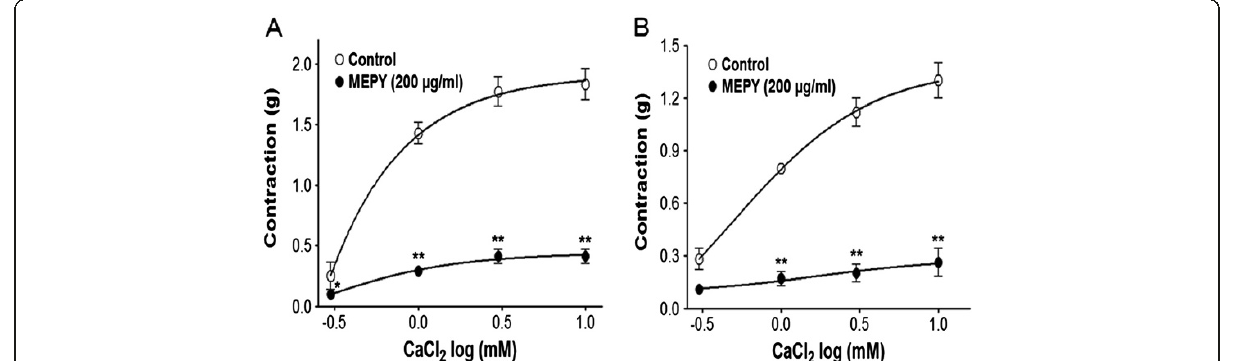
Figure 5 Inhibitory effect of MEPY (200 μ g/ml) on the contraction induced by extracellular Ca 2+ addition (0.3 – 10 mM) in endothelium- denuded rat aortic rings pre-contracted by phenylephrine (PE, 1 μ M) (A) or KCl (60 mM) (B) in Ca 2+ -free Krebs-Henseleit solution. Values are expressed as mean ± SEM (n = 5 – 7). * P < 0.05, ** P < 0.01 vs.